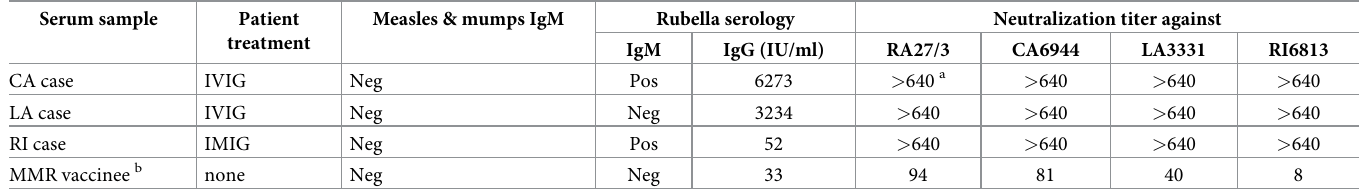
a The patient sera completely neutralized the indicated viruses at the highest dilution of 1:640 used in the neutralization experiments. The precise titers were not determined. b Serum from a typical healthy